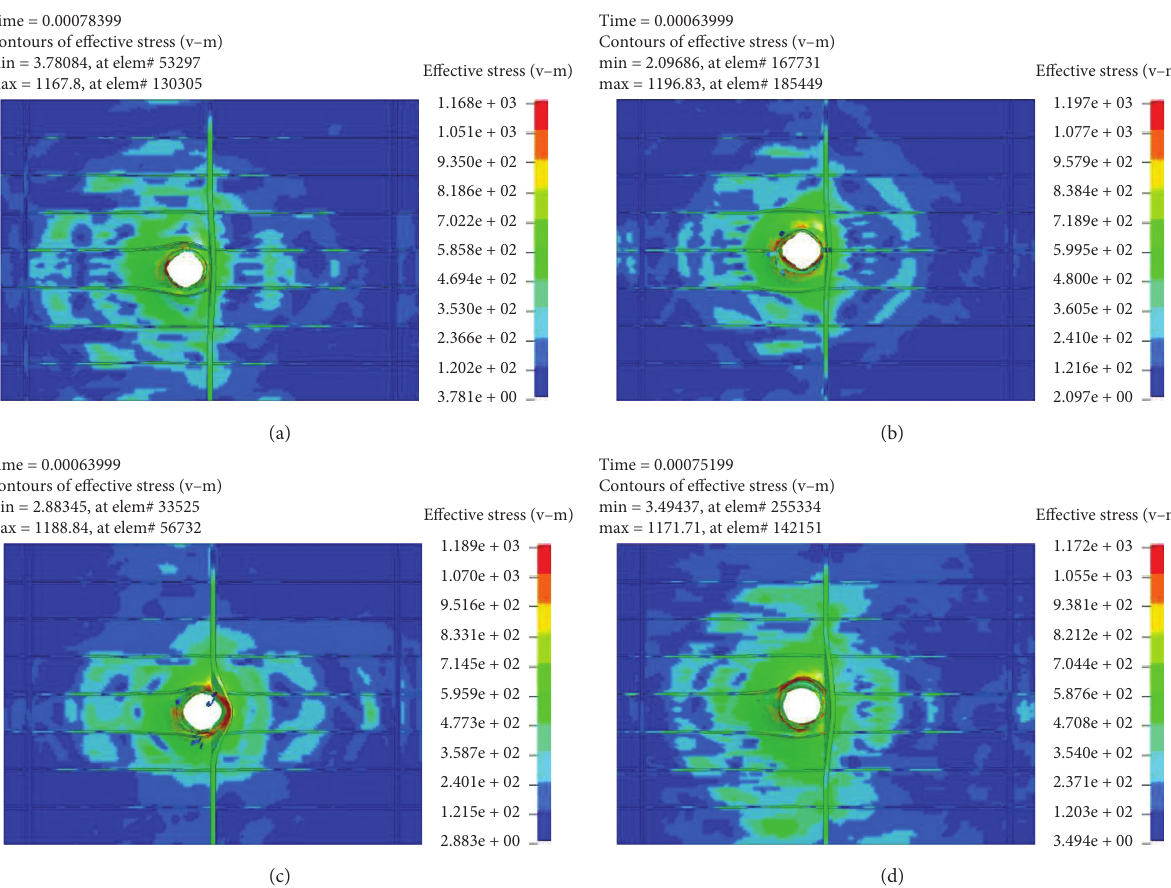
Figure 4: Target plate stress cloud chart. (a) Working condition 1. (b) Working condition 3. (c) Working condition 5. (d) Working condition